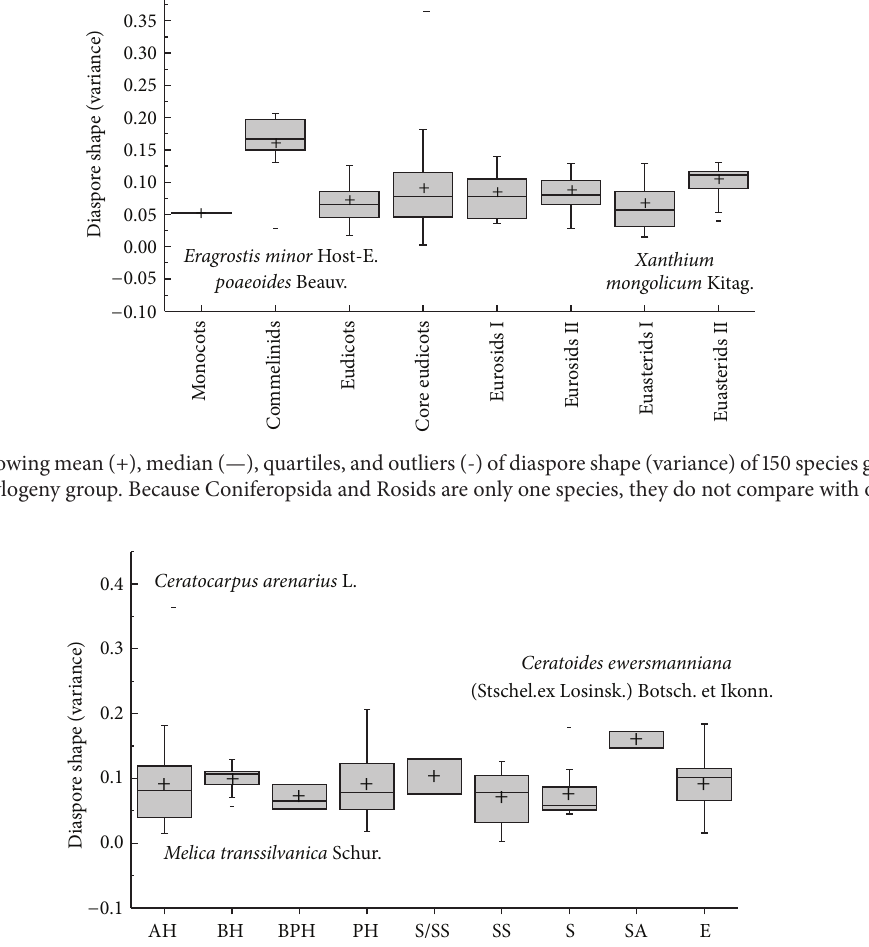
Figure 6: Box plots showing mean (+), median (—), quartiles, and outliers (-) of diaspore shape (variance) of 150 species grouped by different vegetative periods. Because annual-biennial (ABH) species is only one species, it does not compare with others. AH = annuals; ABH = annuals/biennials; BH = biennials; BPH = biennials/perennials; PH = perennials; S = shrubs; SS = semishrubs; SA = small arbor; AE = annuals ephemerals; ABE = annuals/biennials ephemerals; BE = biennial ephemerals.